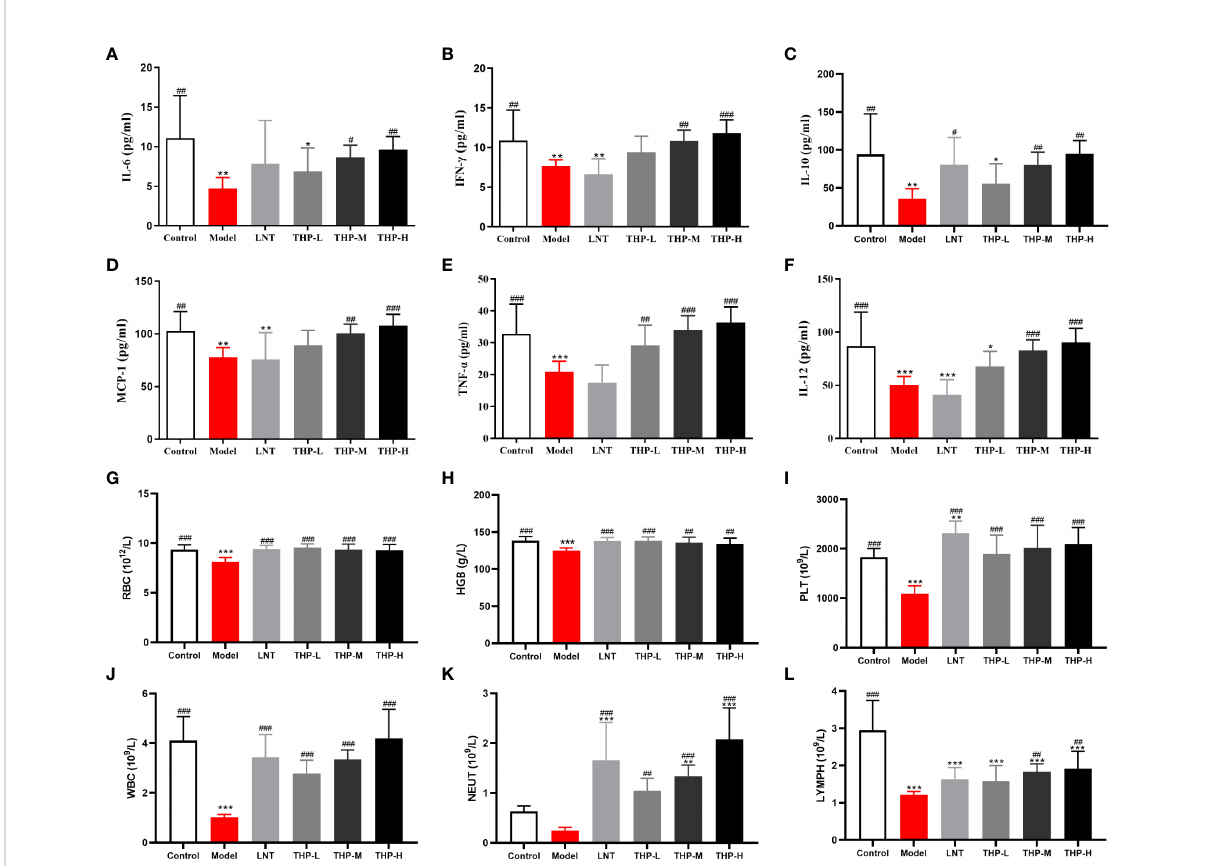
FIGURE 8 Effect of THP on CTX-induced immunosuppression through humoral immunity. (A) IL-6. (B) IFN- g . (C) IL-10. (D) MCP-1. (E) TNF- a . (F) IL-12. (G) RBC. (H) HGB. (I) PLT. (J) WBC. (K) NEUT. (L) LYMPH. Each value is presented as the mean ± SD. *P < 0.05, **P < 0.01, ***P < 0.001 versus